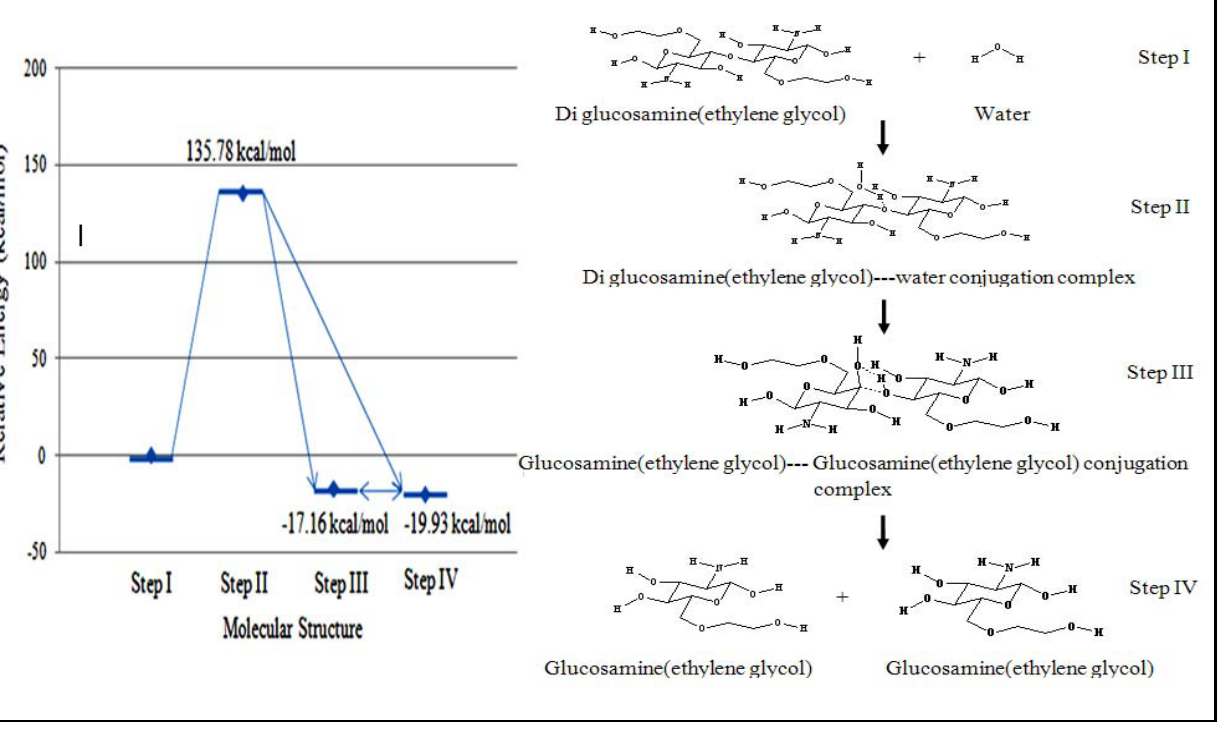
4. Relative energies of reaction intermediates during the hydrolysis of diglucosamine(ethylene glycol) under pH neutral conditions calculated with B3LYP/6- 31G//PM3. The reaction mechanism involves four steps listed